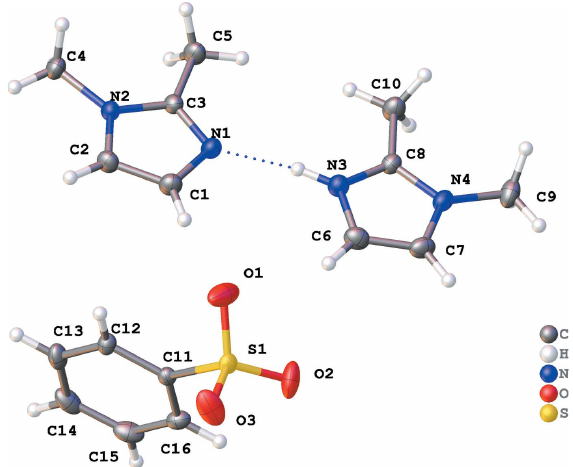
Figure 1 The title compound shown with 50% probability ellipsoids. Only the major component is shown.